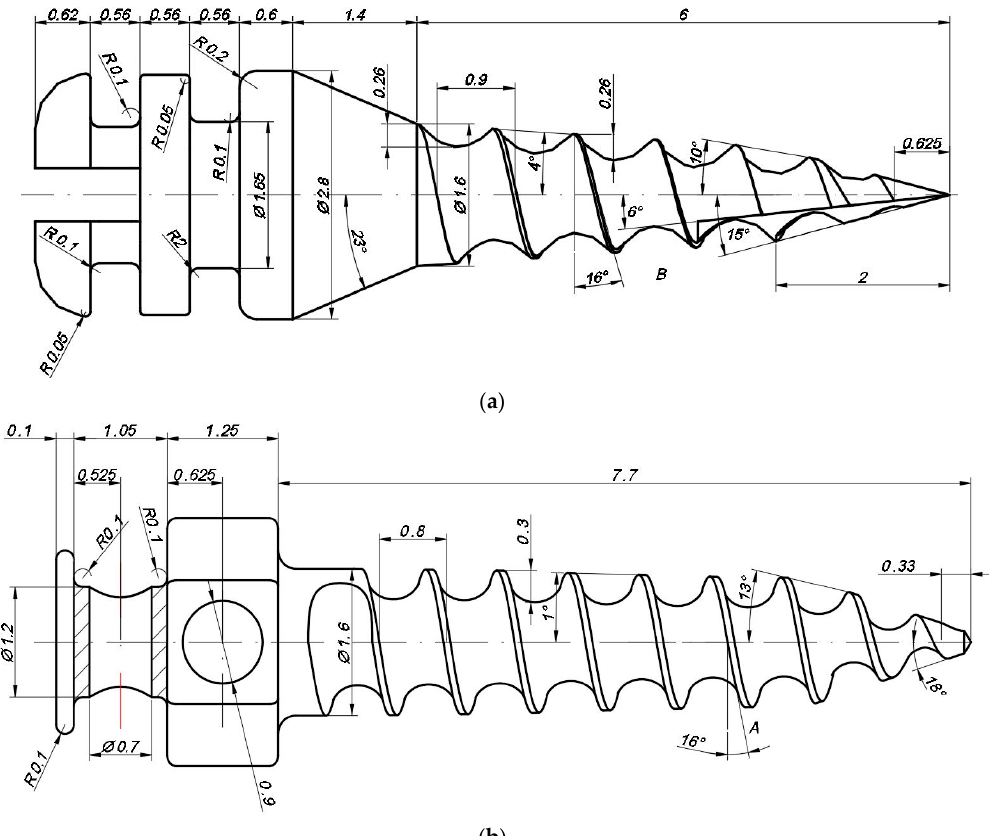
Figure 2. Detailed geometry. ( a ): Tomas ® -pin, ( b ): Perfect Anchor. The acquired values are used for calculation of the thread-shape factor (TSF), which represents the ratio of the thread-bearing depth and pitch. This factor is characterized as the bearing evaluation factor for the implant–bone system, and it is particularly important for primary stability [20]. Table 1. Values of geometric parameters established with measuring. Implant Type/Geometric Parameter